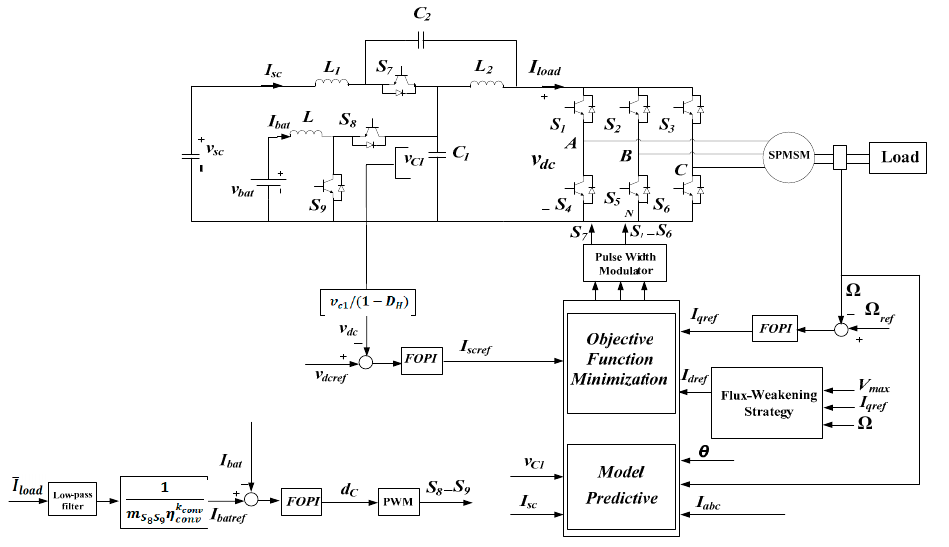
Figure 3. The control scheme for multi-source Bq-ZSI.